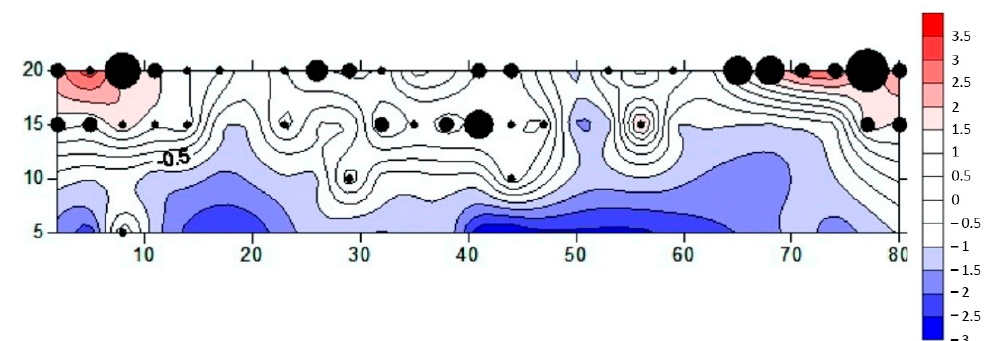
Figure 5. Graphical representation of the incidence and intensity of the attacks by X. germanus on grapevines in the studied field. The X and Y axes represent the dimensions of the vineyard, in meters. Black circles show the position and intensity of the infestation, while the red color indicates the aggregation areas where the 3 × 3 plots with the highest rate of infestation were concentrated. The blue areas indicate those parts of the vineyard where no pattern of aggregation was identified.